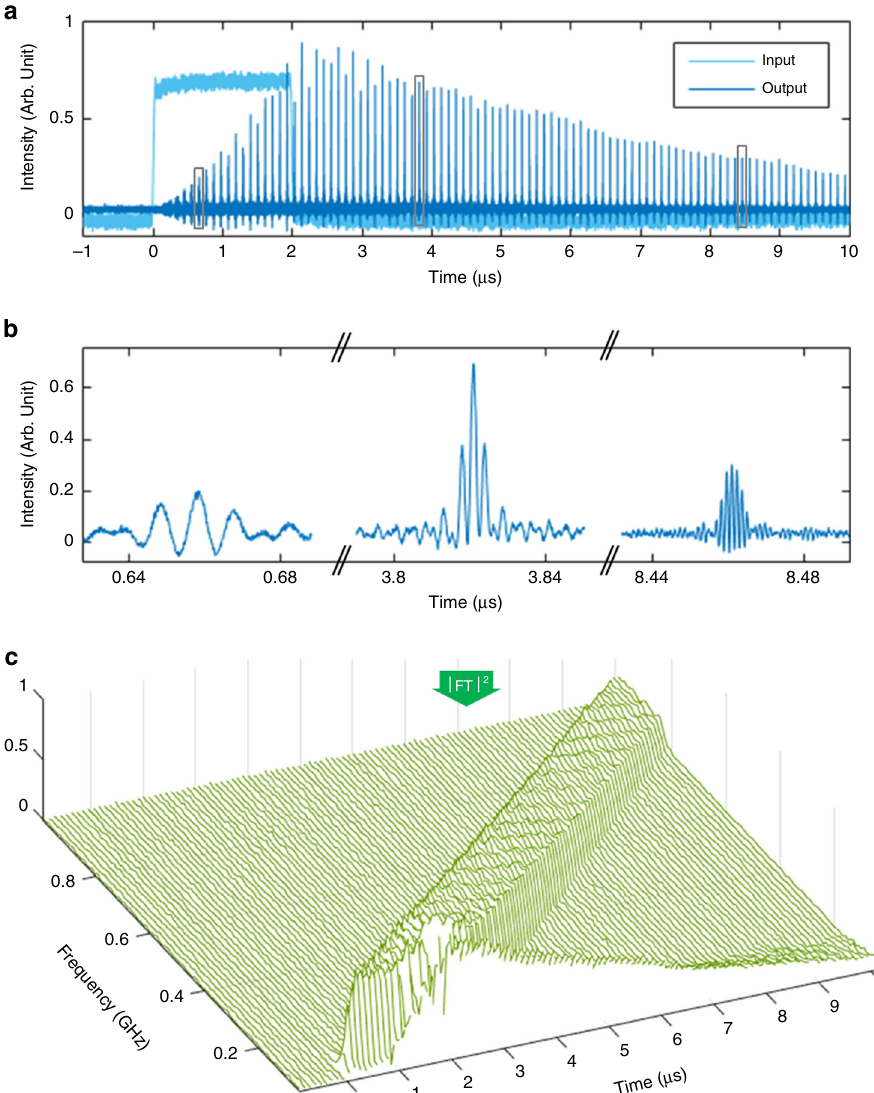
Fig. 2 Demonstration of time-to-frequency mapping in FSLs. a in dark blue, temporal evolution of the output waveforms after heterodyning with the CW laser. The intensity of the input modulation signal (here, a square-like or fl at-top signal) is plotted in light blue. b selected individual output waveforms after heterodyning with the CW laser. c instantaneous power spectrum of the output waveforms after heterodyning (in green). The output individual waveforms are numerically extracted from the recorded time trace, and Fourier transformed. The frequency axis represents the baseband frequency (i.e., the relative optical frequency with respect to f 0 ). Notice that the input signal was imprinted onto the CW laser by means of an AOM driven at 80 MHz, which explains the shift of the lowest output frequencies from DC to 80 MHz. For any time lower than 2 µ s, only the leading edge of the modulation signal has entered the FSL, resulting in a truncation of the ( fl at-top) optical output spectrum. At later times, the instantaneous spectrum shifts by 1/ τ c ( = 9.482 MHz) every 1/ f s ( = 105.5